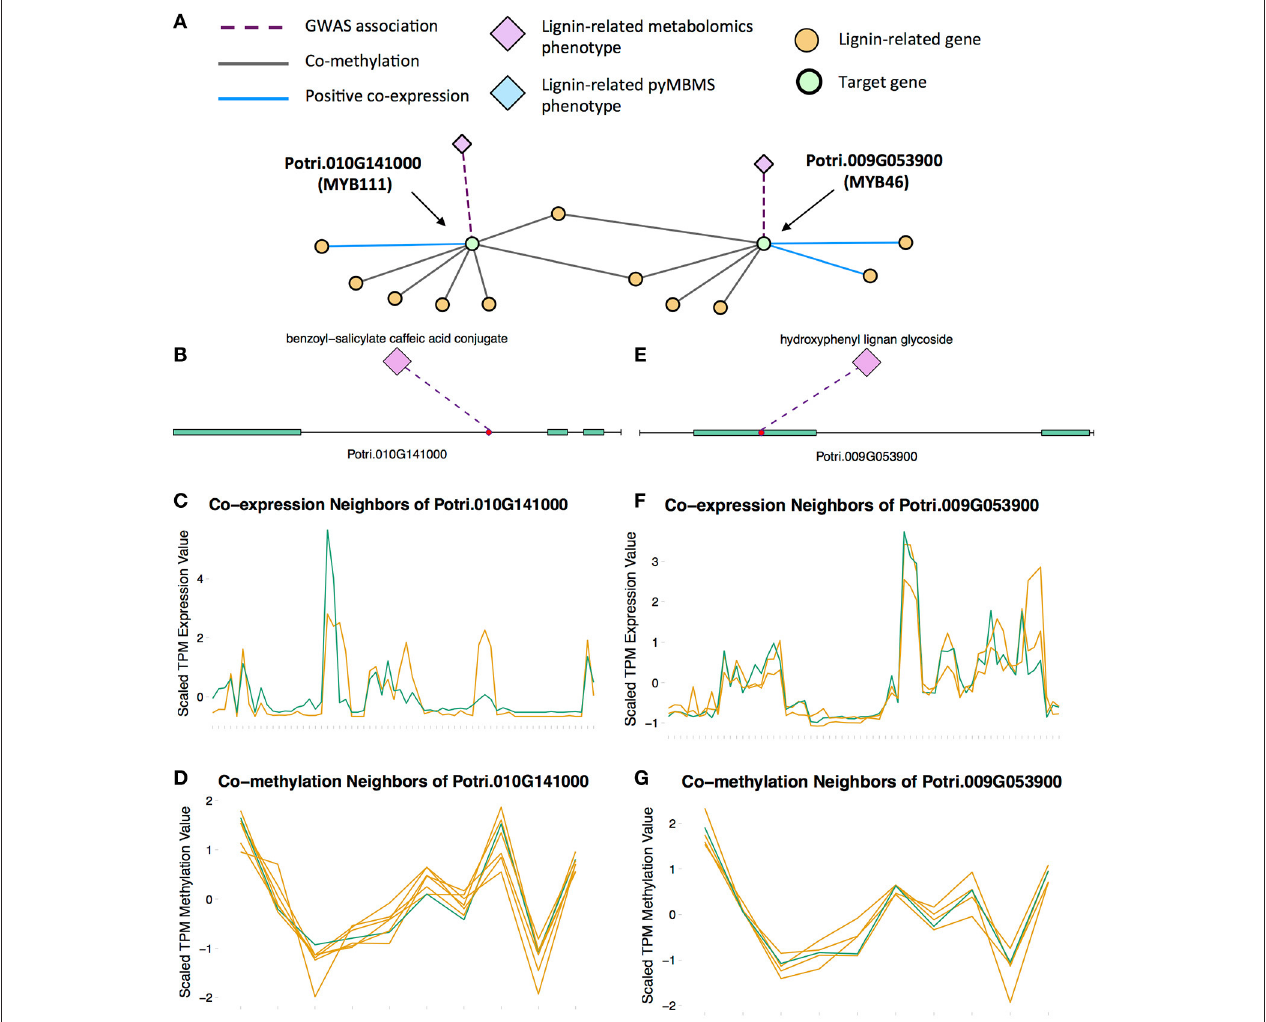
FIGURE 7 | (A) Lines of evidence for Potri.009G053900 (homolog of Arabidopsis MYB46) and Potri.010G141000 (homolog of Arabidopsis MYB111). (B) GWAS associations of Potri.010G141000 with a lignin-related metabolite ( Table 1 ). (C) Co-expression of Potri.010G141000 with a lignin-related gene ( Table 2 ). (D) Co-methylation of Potri.010G141000 with six lignin-related genes ( Table 3 ). (E) GWAS associations of Potri.009G053900 with a lignin-related metabolite ( Table 1 ). (F) Co-expression of Potri.009G053900 with two lignin-related genes ( Table 2 ). (G) Co-methylation of Potri.009G053900 with four lignin-related genes ( Table 3 ). In line plots, the green lines represent potential targets Potri.009G053900/Potri.010G141000 and yellow lines represent lignin-related genes.